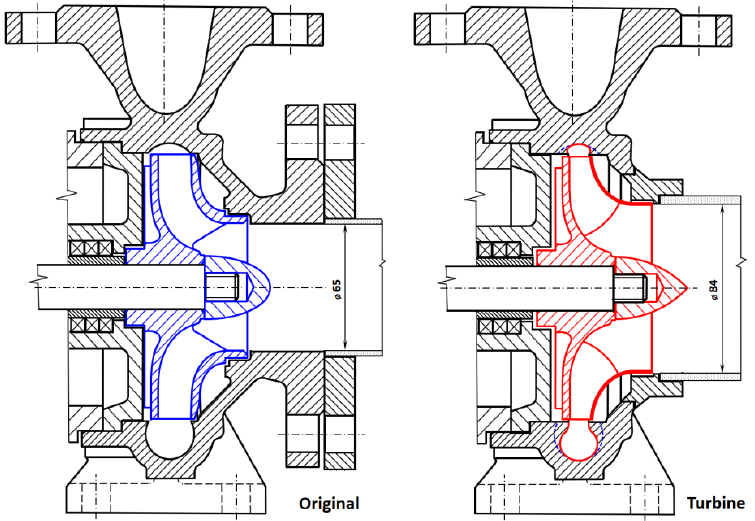
Figure 6. Cross-section of the Original PAT ( left ) and the Turbine after modification ( right ).